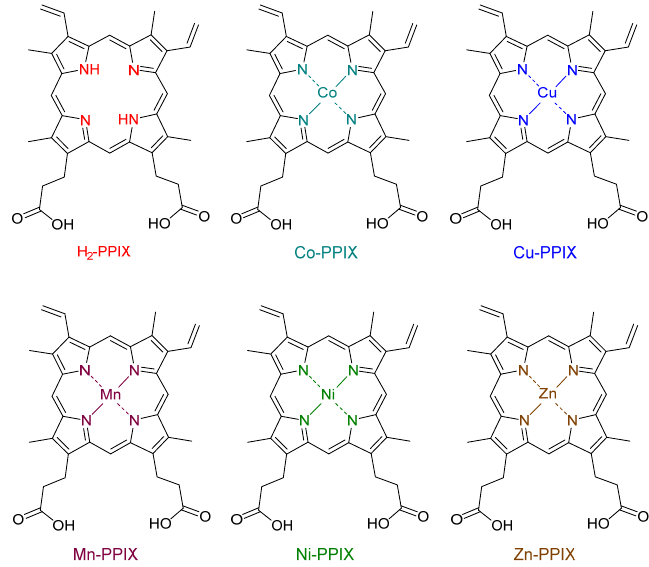
Figure 19. Molecular structures of protoporphyrin IX and the metallated derivatives, which were encapsulated into polymeric nanocapsules and tested against P. falciparum . [55]. Differently from malaria parasites, the host does not rely on hemozoin crystal formation for hemin detoxification. The host catalytically degrades hemin into biliverdin (BV) [197]. Nanomolar